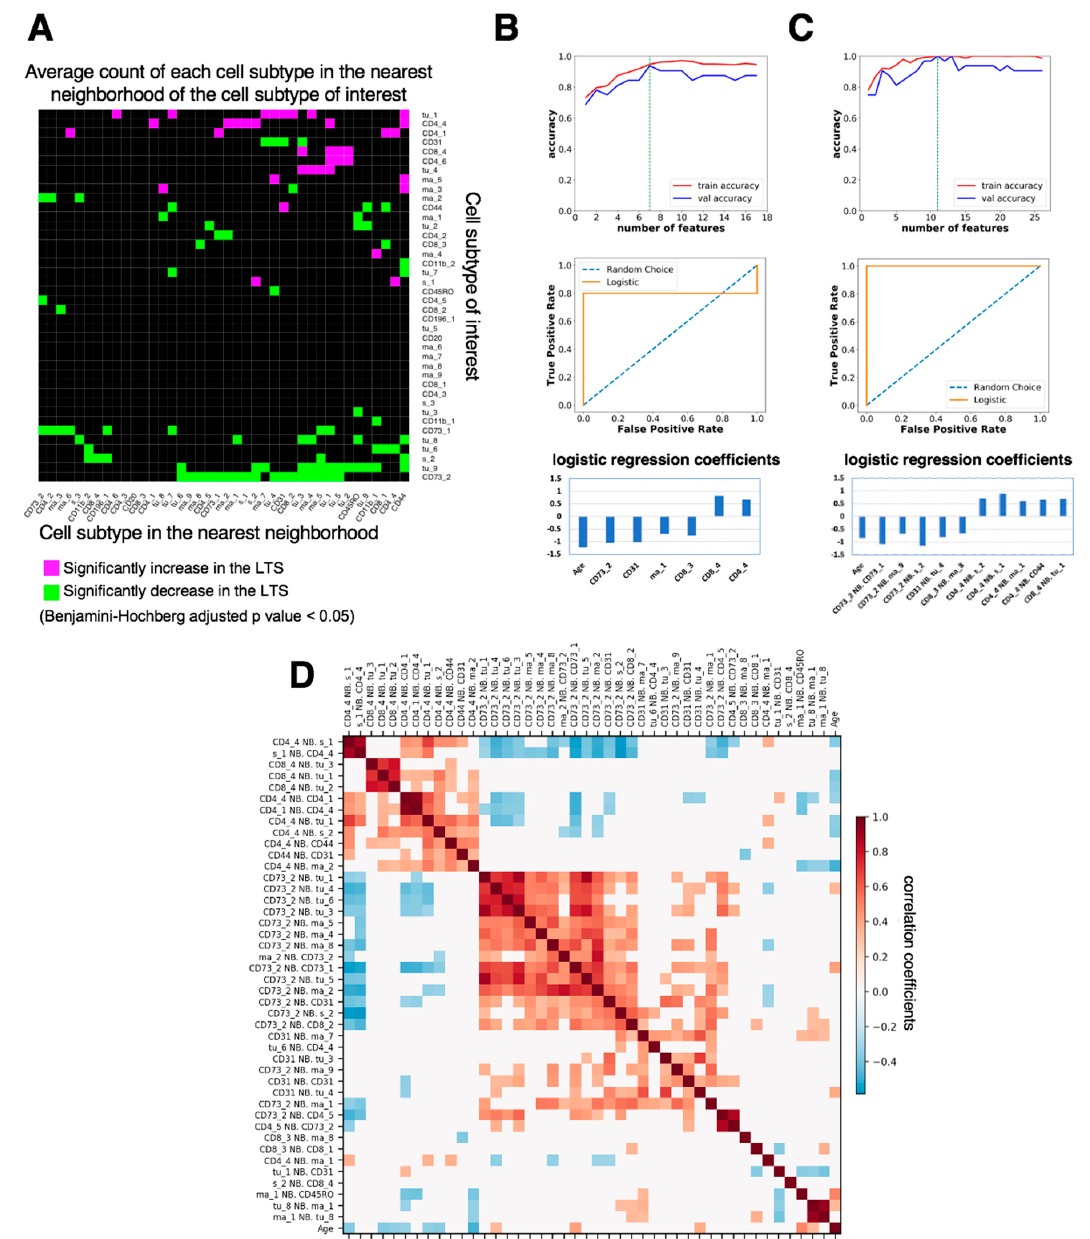
Figure 6. Comparison of nearest-neighbor cell-cell interactions between long-term survivors (LTS) and short-term survivors (STS) and feature selection for patient survival prediction. ( A ). Map of significant increases and decreases in nearest-neighbor interactions, computed as the average number of cell subtype X in the nearest neighbor of cell subtype Y (distance between the center of X and Y less than 20 µm), that are significantly (Benjamini-Hochberg adjusted p value < 0.05) increased (magenta) or decreased (green) in LTS compared with STS. ( B ). ( Top ) Number of cell density features selected by recursive feature elimination as a function of training (red) or validation (blue) accuracy. The optimal number of features is indicated by the green dashed line. Validation was done by leave-one-out cross validation. ( Middle ) Receiver operating characteristic (ROC) curve for the test set. ( Bottom ) Logistic regression coefficients of the features selected by the model. ( C ) ( Top ) Number of features of nearest-neighbor cell-cell interactions selected by recursive feature elimination as a function of training (red) or validation (blue) accuracy. The optimal number of features is indicated by the green dashed line. Validation was done by leave-one-out cross validation. ( Middle ) Receiver operating characteristic curve for the test set. ( Bottom ) Logistic regression coefficients of the features selected by the model. ( D ). Spearman correlation between the features that both correlate with patient survival (absolute correlation coefficient > 0.2). White color indicates correlation coefficient = 0 or p ≥ 0.05. Neighborhood features were ordered by hierarchical clustering with the Ward